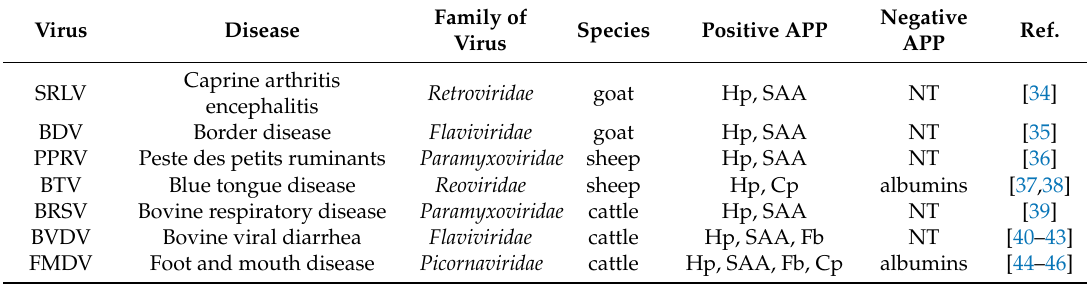
Table 1. Changes in acute phase protein (APP) levels in viral diseases of dairy ruminants.